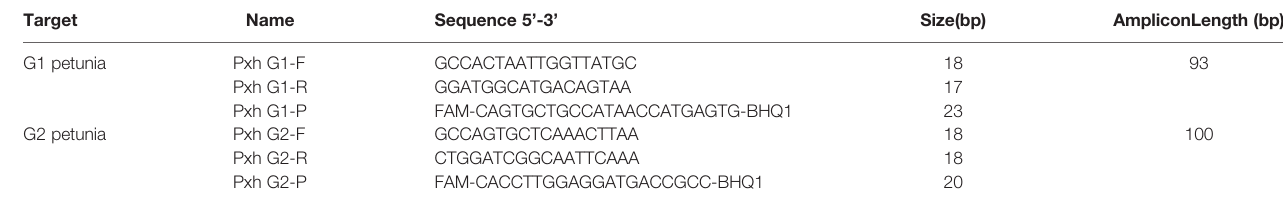
TABLE 2 | Primer and probe sequences for the event-speci fi c PCR methods. Target